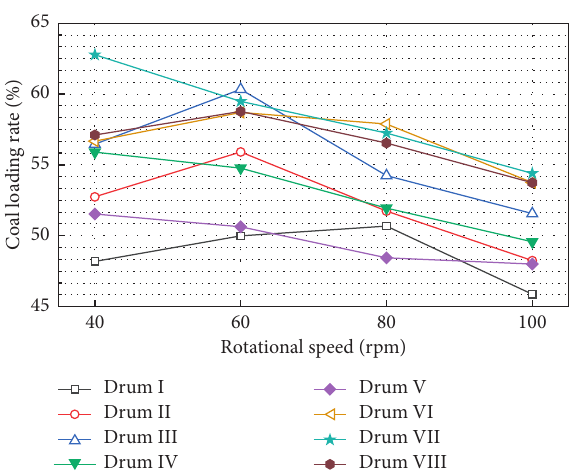
Figure 7: The coal loading rate curve of eight drums at different rotational speeds. Table 3: The statistical analysis of particle velocities in three directions and coal loading